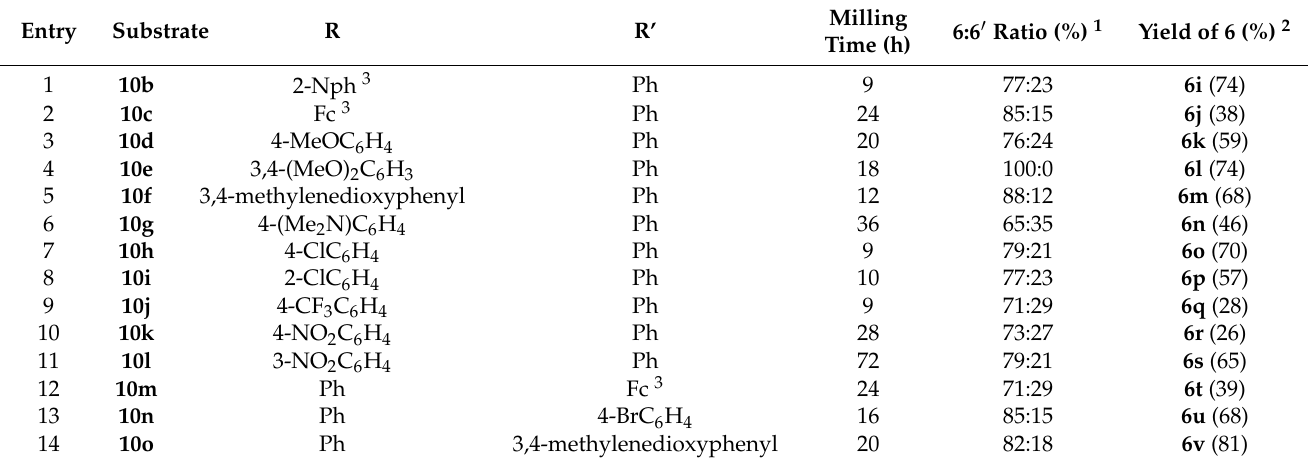
Table 3. Mechanochemical (3 + 2)-cycloadditions of 10b – 10o with model nitrile imine 1b